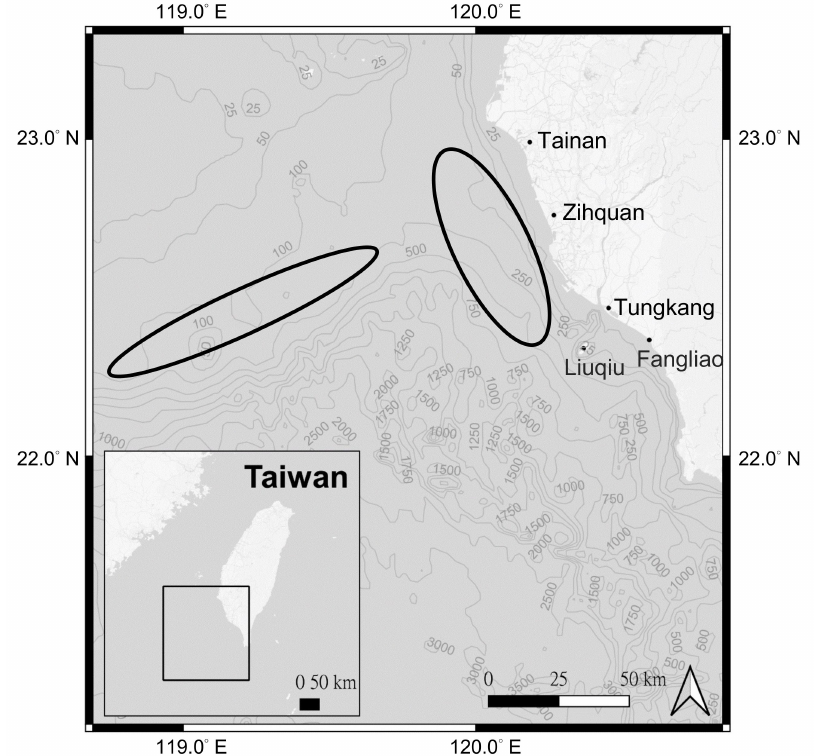
Figure 2. Black circles indicate the major fishing areas of P. macrocephalus and A. nibe from the trawlers based in Zihquan, Tungkang, Fangliao and other ports in southwestern Taiwan. The market samples used in this study came from these fishing